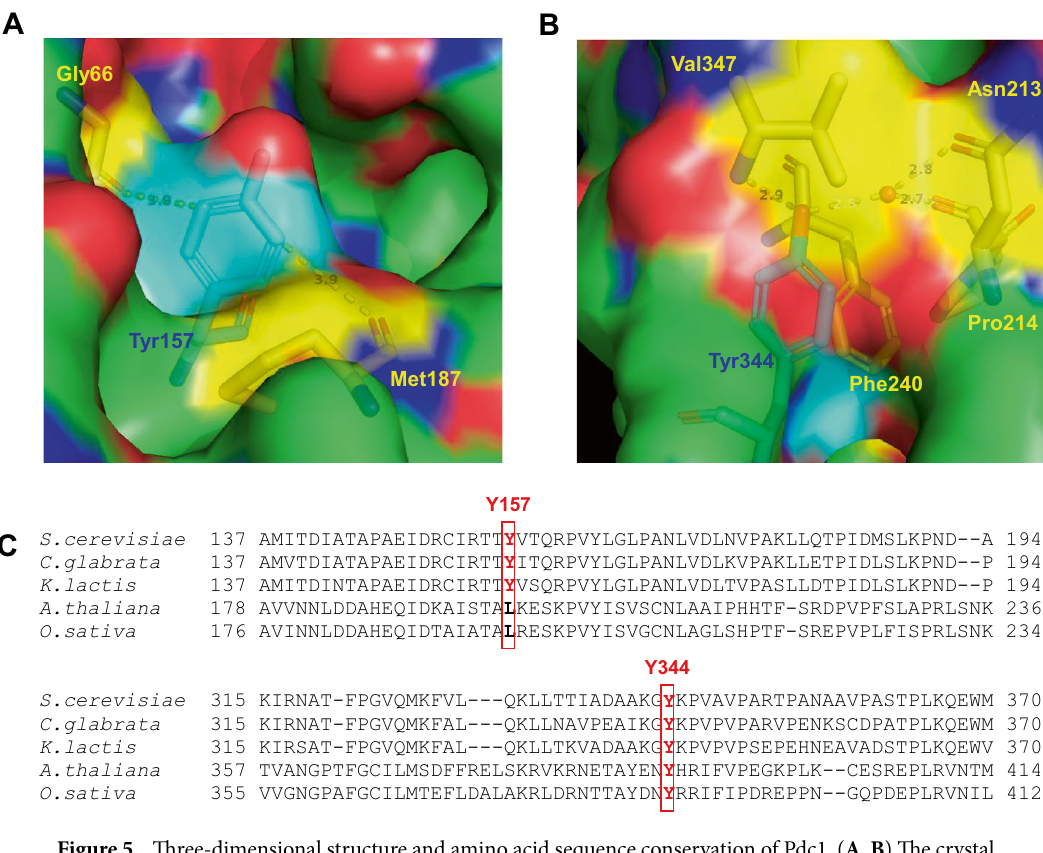
Figure 5. Three-dimensional structure and amino acid sequence conservation of Pdc1. ( A , B ) The crystal structures of Pdc1 from S. cerevisiae with the PDB ID code of 2VK1 61 were shown with the molecular surface of protein. Oxygen or nitrogen atom is colored by red or blue. The values nearby dotted lines indicate the distances between two atoms. ( A ) Local structure around Tyr157 was exhibited with Gly66, Tyr157, and Met187 in a stick model. Carbon atoms were colored by cyan, yellow, or green in Tyr157, Gly66 and Met187, or the other residues, respectively. The side chain of Tyr157 is located close to Gly66 and Met187. ( B ) The structure surrounding Tyr344 was shown with Asn213, Pro214, Phe240, Tyr344, and Val347 in a stick model. Carbon atoms were colored by cyan in Tyr344, yellow in Asn213, Pro214, Phe240, and Val347, or green in the other residues, respectively. ( C ) Amino acid sequences of Pdc1 from S. cerevisiae, Candida glabrata , Kluyveromyces lactis , Arabidopsis thaliana , and Oryza sativa were aligned using the sequence alignment tool Align in the Universal Protein Resource (UniProt) (https:// www. unipr ot. org/align/) and the part of alignment was shown. Tyr157 and Tyr344 in Pdc1 from S. cerevisiae and their corresponding residues in PDCs from the other species were highlighted by red